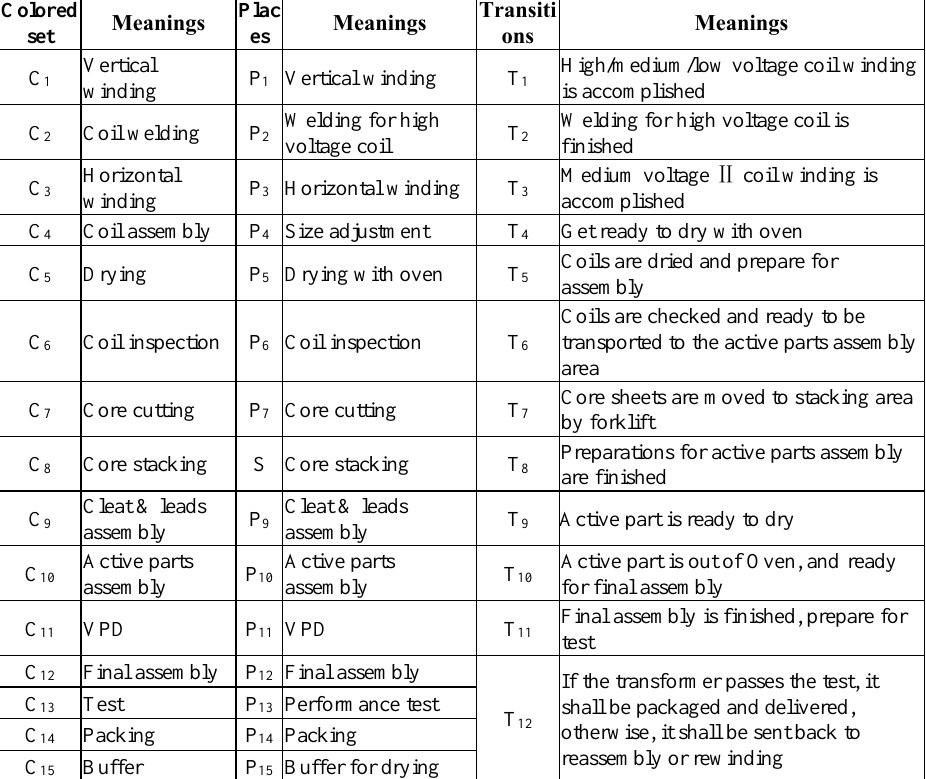
Table 2. Meanings of places and transitions.